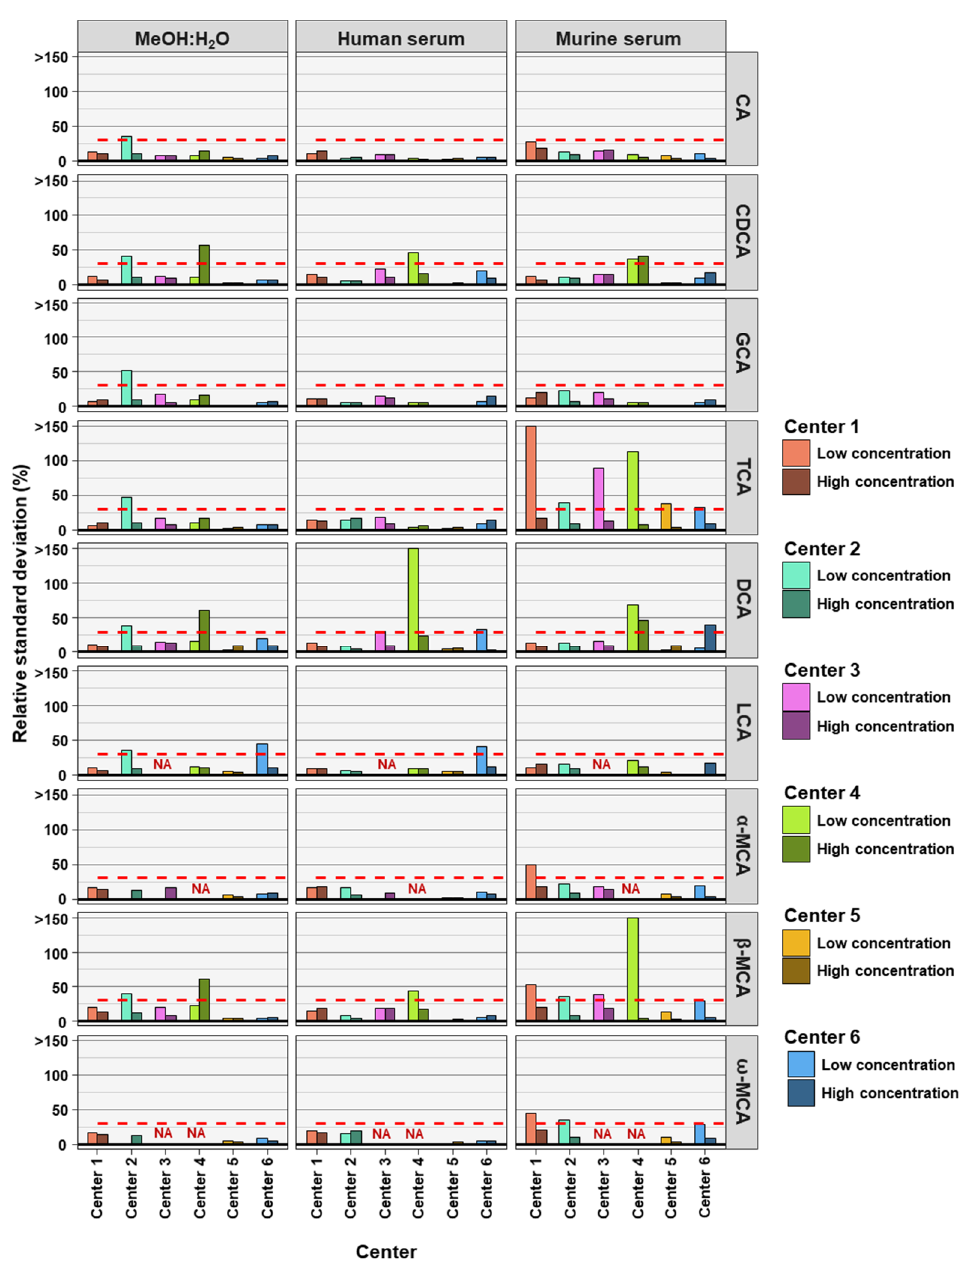
Figure 1. The precision of bile acid analyses of each assessing center. Relative standard deviations (n = 6) of the nine bile acids spiked into MeOH:H 2 0 solvent as well as human and murine serum at high and low concentration levels. The red dashed line represents a relative standard deviation of 30%. NA = not applicable, those BAs were not covered in the analysis of that center.